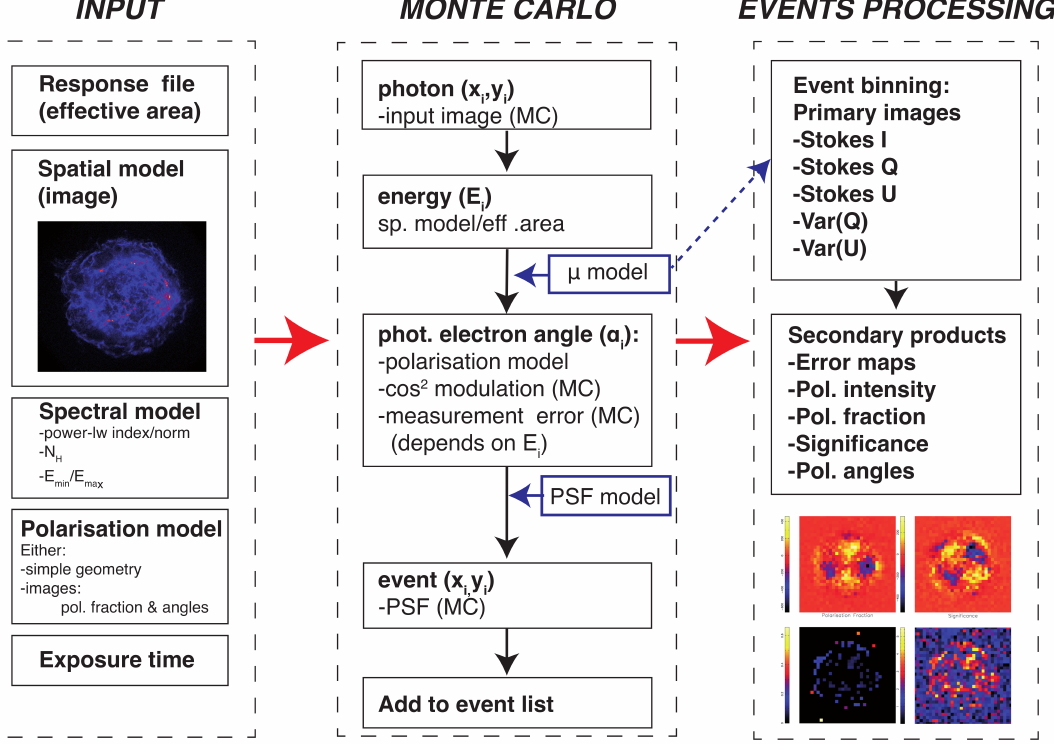
Figure 2. Schematic view of the xpolim